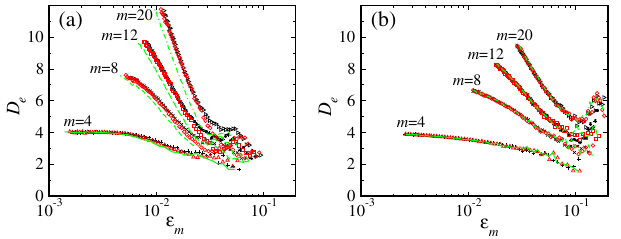
FIG. 7. Effective dimension D as a function of the resolution e ε for g ¼ 0 . 8 and g ¼ 1 . 3 in panels (a) and (b), respectively. m The system size is N ¼ 4000 (black), N ¼ 16000 (red), and N ¼ 64000 (green). The different symbols belong to different FIG. 8. Projection of the collective dynamics on the plane ð R Þ for g ¼ 0 . 7 in an ensemble of 16000 oscillators. The embedding dimensions m marked in the figure. The curves for the 1 ; R 3 same embedding dimension group, together with a similar slope dots show 16384 time-discrete R 1 , R 3 pairs sampled every 2.5 irrespective of the system size. time